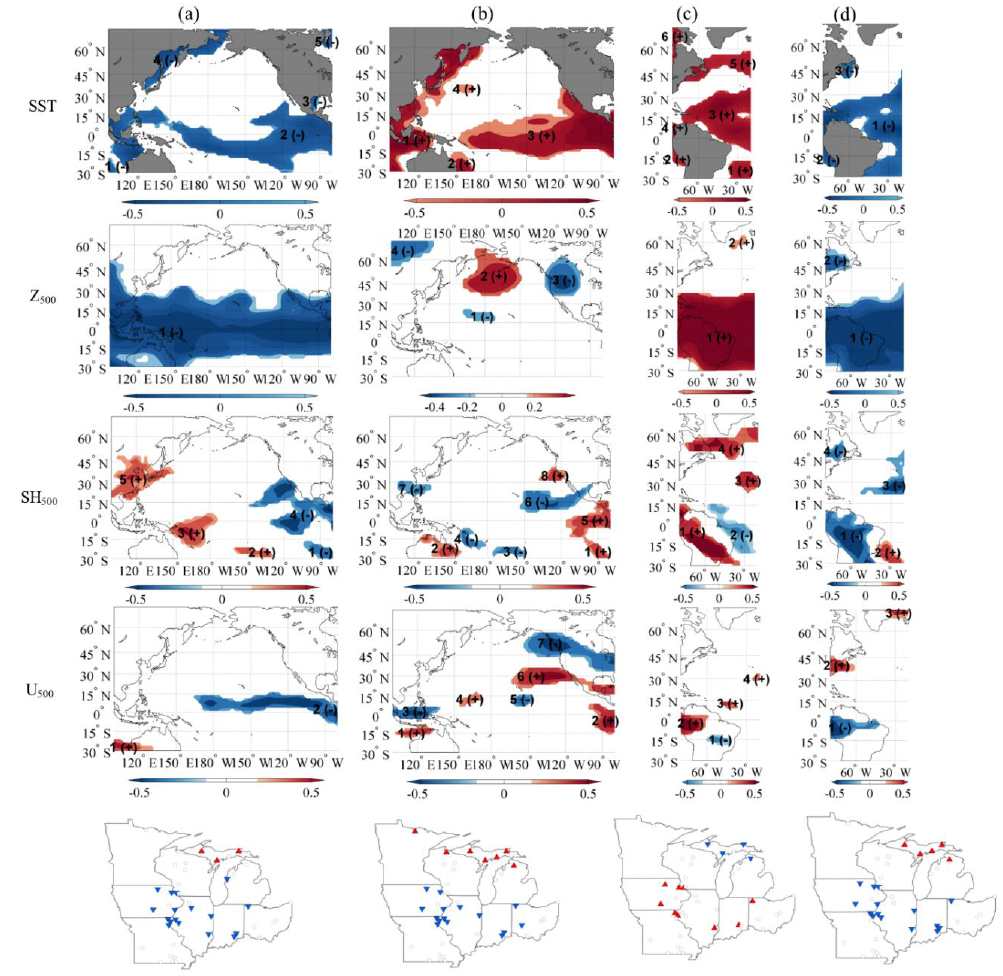
Figure 3. Heterogeneous correlation map developed for ( a ) Pacific September–November, ( b ) Pacific December–February, ( c ) Atlantic September–November, ( d ) Atlantic December–February SST, Z 500 , SH 500 , and U 500 with Midwest April–August streamflow. Significant regions with positive (negative) correlations are represented by red (blue). Significant streamflow stations are represented by red upward (blue downward) triangles.